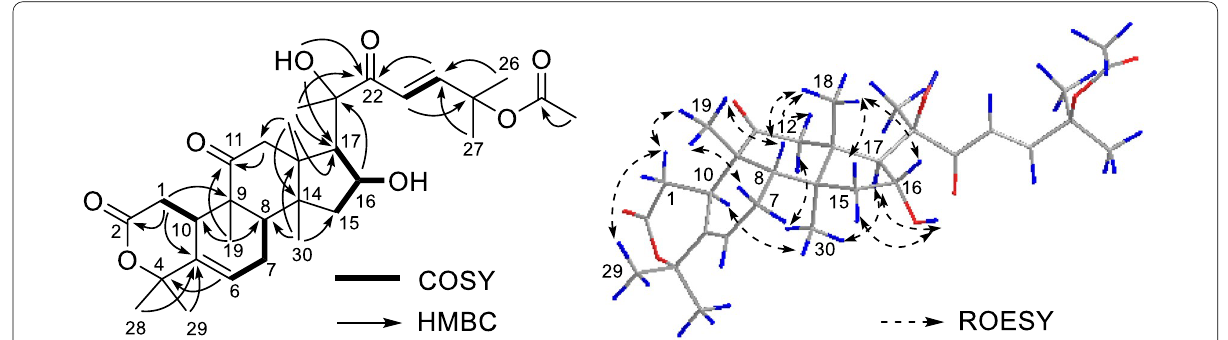
Fig. 3 Key 2D NMR correlations of compound 1